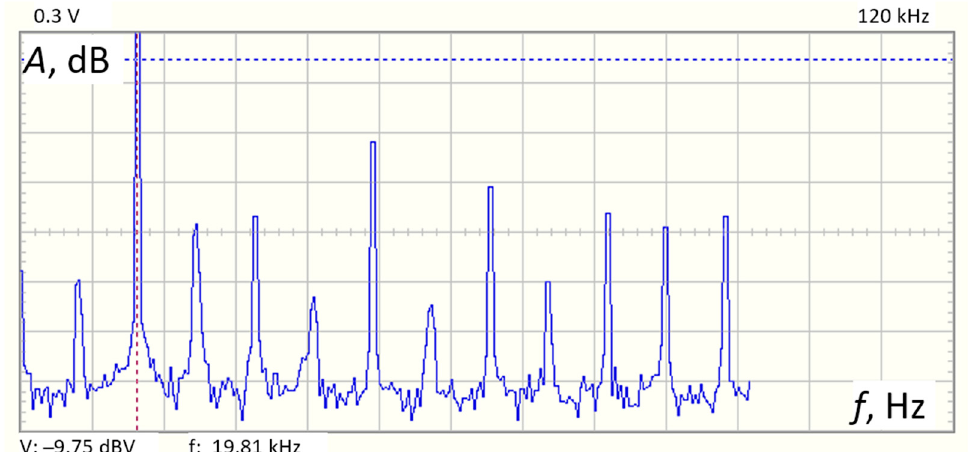
Figure 1. Ultrasonic multifrequency specter for the frequency of 19.8 kHz: A—amplitude; f—frequency.